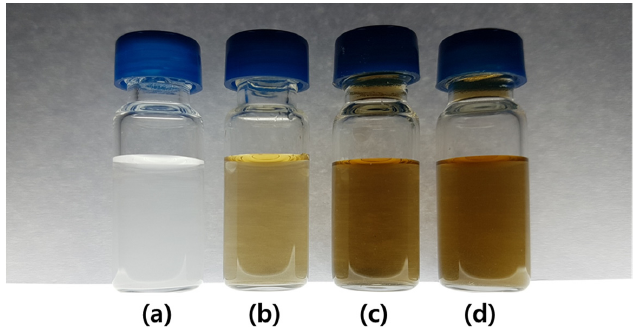
Figure 1. Digital photographs of the ( a ) dicalcium phosphate (DCP) microparticles, ( b ) DCP5 ‐ rGO2.5 composites, ( c ) DCP5 ‐ rGO5 composites, and ( d ) DCP5 ‐ rGO10 composites in deionized water.